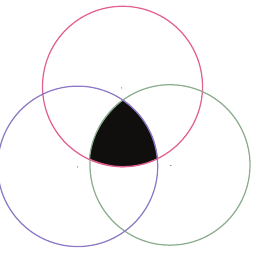
Figure 6: Top view of the RGB color trajectory overlapping.